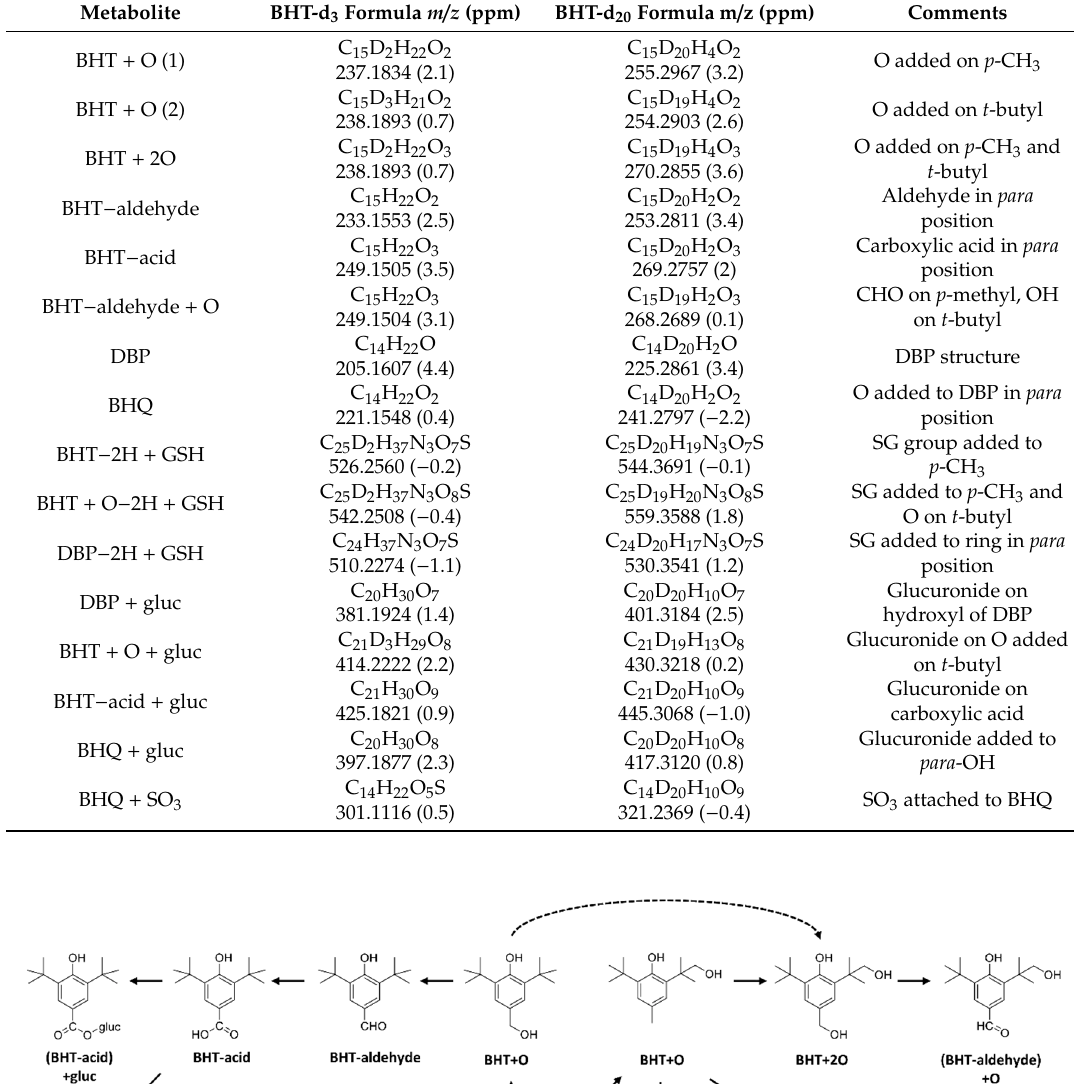
Table 2. High-resolution mass spectrometry data using isotope-labeled BHT analogs.